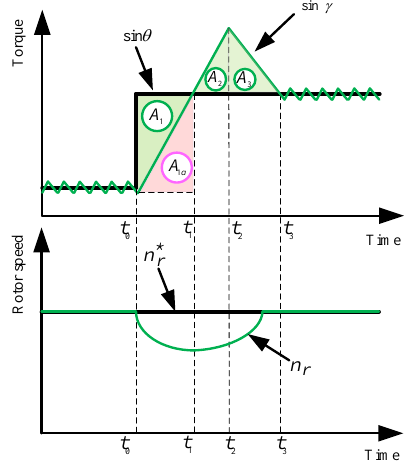
Figure 13. Optimal response to load sudden change for the torque angle.